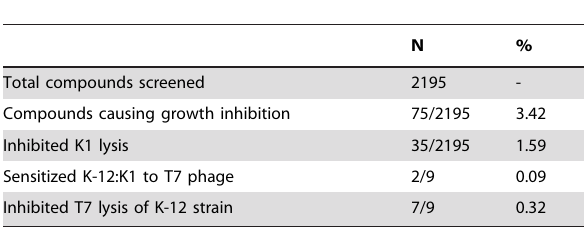
Table 1. Summary of high-throughput